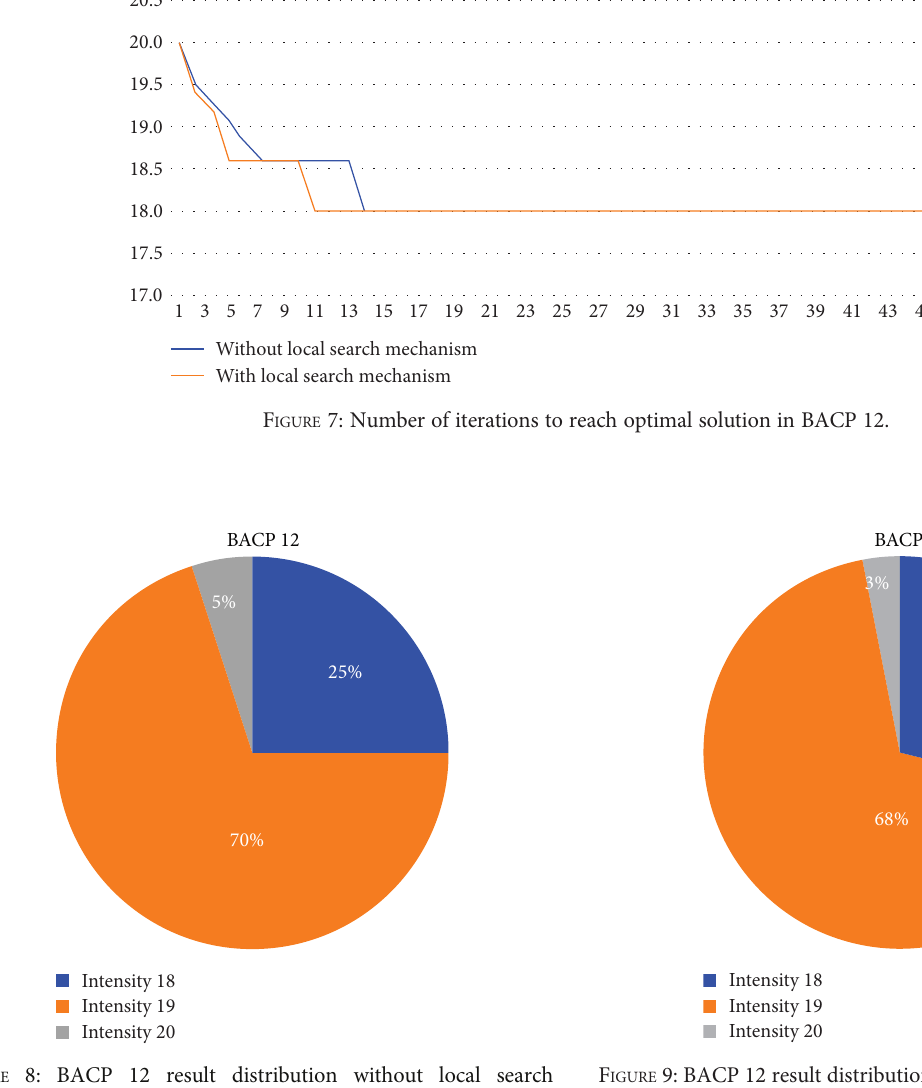
F IGURE 8: BACP 12 result distribution without local search mechanism.